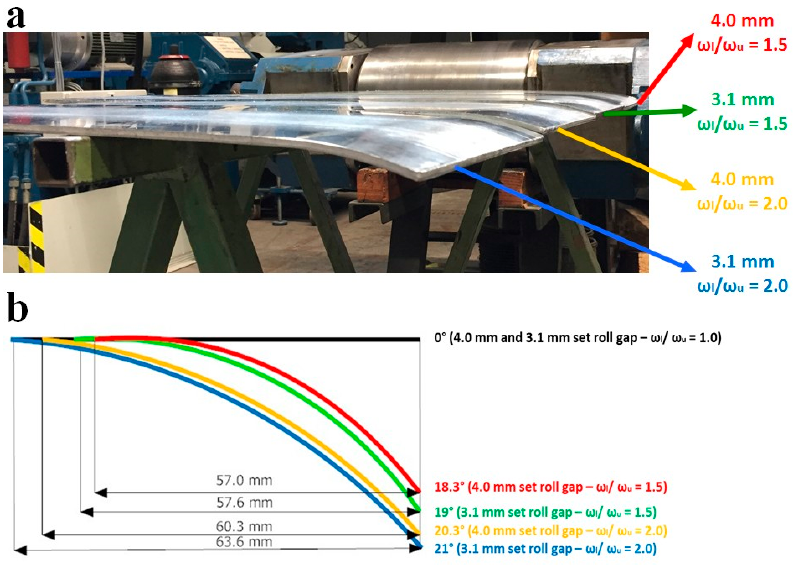
Figure 3. Ski e ff ect on rolled plates ( a ) and schematic presentation of ski e ff ect with measured lengths Figure 3. Ski effect on rolled plates ( a ) and schematic presentation of ski effect with measured lengths and angles ( b and angles ( b ).